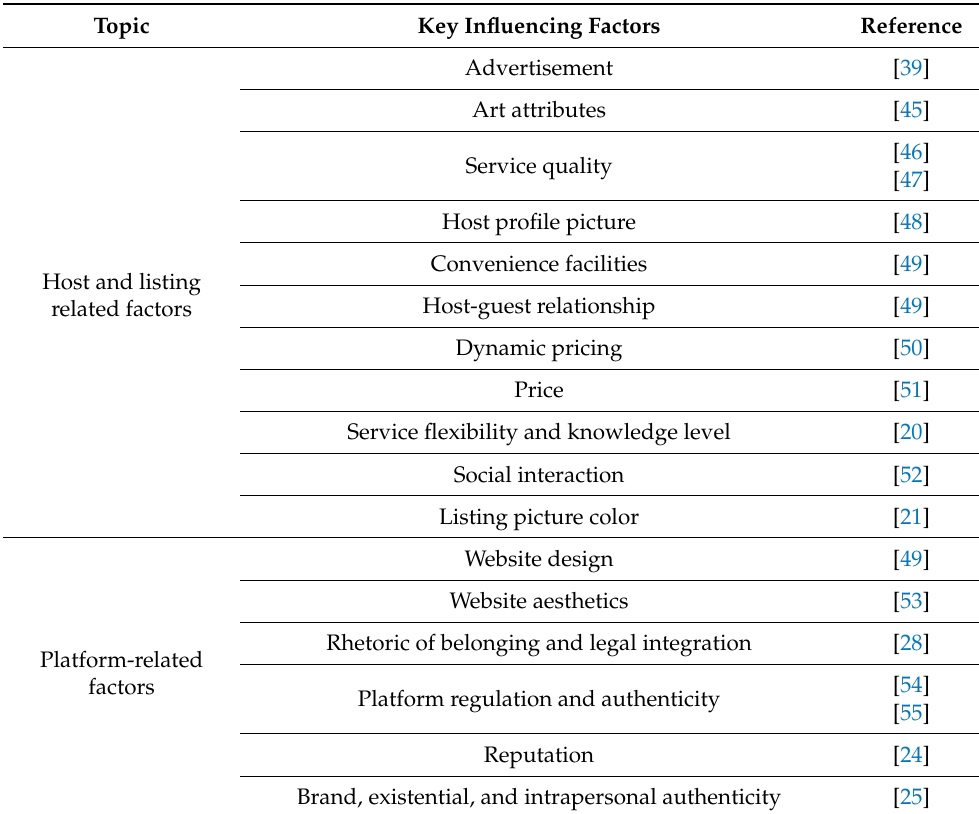
Table 1. Cont. Topic Key Influencing